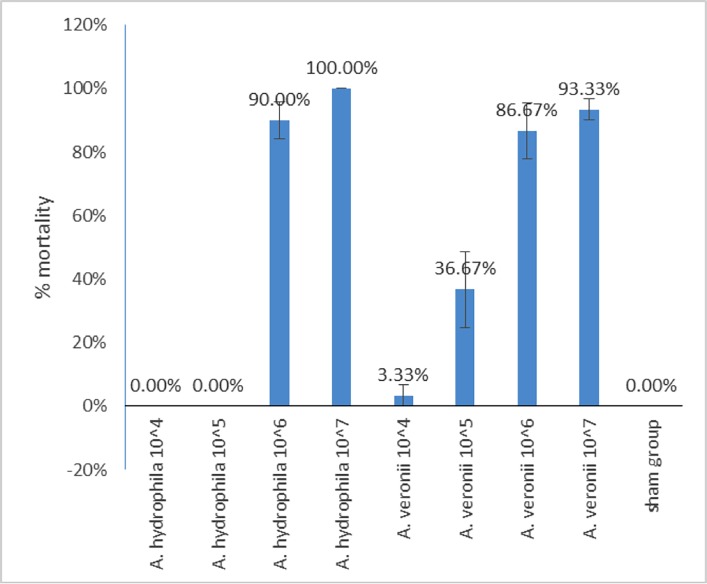
Percent mortalities in catfish challenged with A. hydrophila ML09-119 and A. veronii ML09-123.